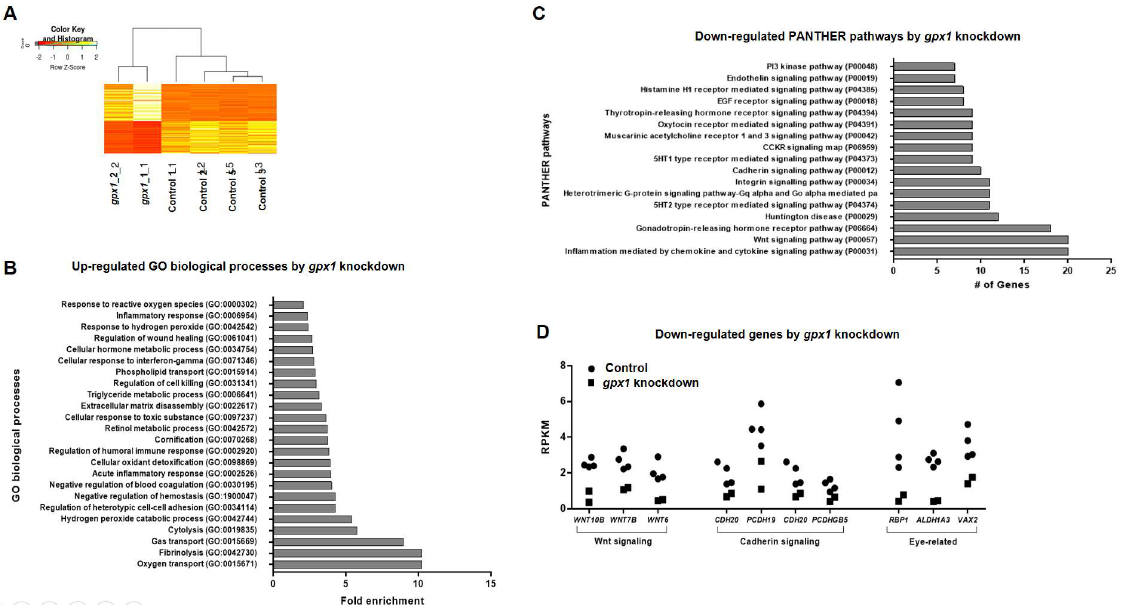
Figure 5. Transcriptomic analyses provide insight into the mechanism of eye development by gpx1 during Xenopus embryogenesis. ( A ) The heat map shows the remarkable difference between the control embryos and gpx1- morphant embryos. ( B ) Transcriptome enrichment analysis using PANTHER software revealed the upregulation of the biological pathways associated with the response to reactive oxygen species, oxygen transport, hydrogen peroxide, hydrogen peroxide catabolic process, and gas transport. ( C ) Transcriptomic analysis using PANTHER software demonstrated the downregulation of signaling pathways, i.e., Wnt, Cadherin, and integrin associated with eye development in gpx1 -depleted embryos. ( D ) Genes associated with Wnt signaling (Wnt10b, Wnt 7b, and Wnt6) showed significantly low RPKM values in gpx1 -depleted embryos compared with the control embryos. A similar case was observed for cadherin signaling-associated genes (CDH20, PCDH19, and PCDHGB5), showing considerably low RPKM values compared with the control embryos. Additionally, genes associated with eye development, such as RBP1, ALDH1A3, and VAX2, exhibited remarkably low RPKM values after gpx1 knockout compared with the control